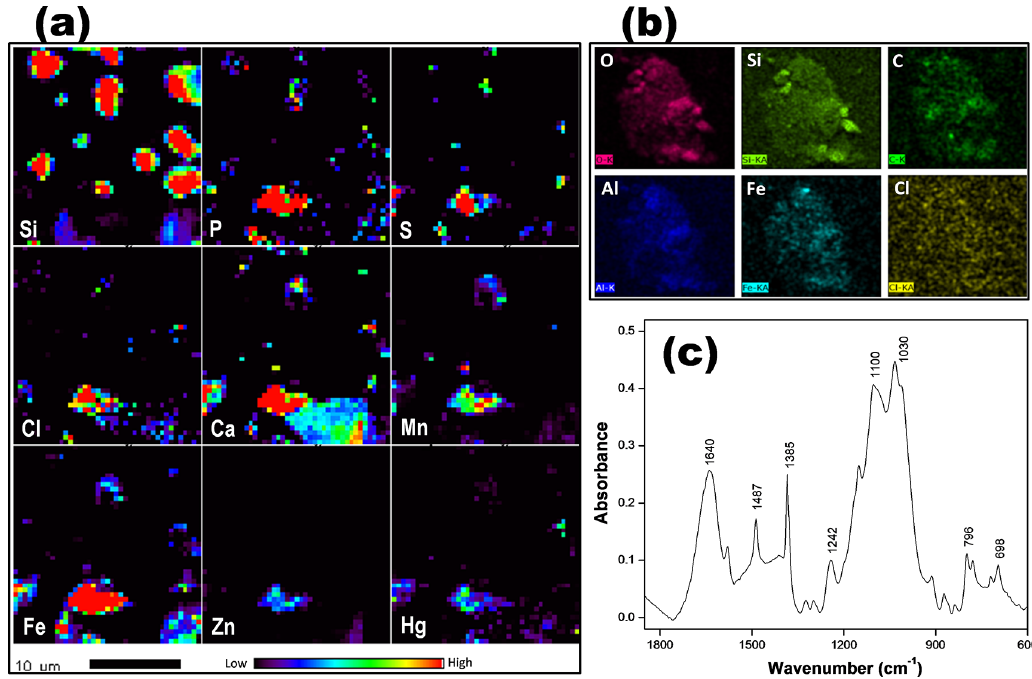
Figure 4. Experiments used to support the hypothesis that organic matter (carbon) is associated with iron oxide minerals and acts as a bridge for Hg sorption. (a) X-ray microprobe fluorescence imaging and elemental analysis (e.g., Hg, Fe, etc.) of selected mineral particles (from EFK23.5) spiked with Hg at 617µgg − 1 (dry wt); (b) scanning electron microscope (SEM) backscattering elemental analysis of a selected cluster of mineral particles showing the association between carbon and Fe, and (c) FTIR spectroscopic analysis of natural organic matter associated with mineral